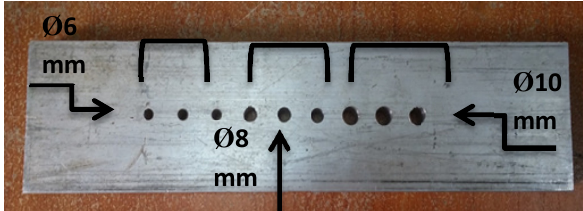
Fig. 5. The Sample of the Workpiece